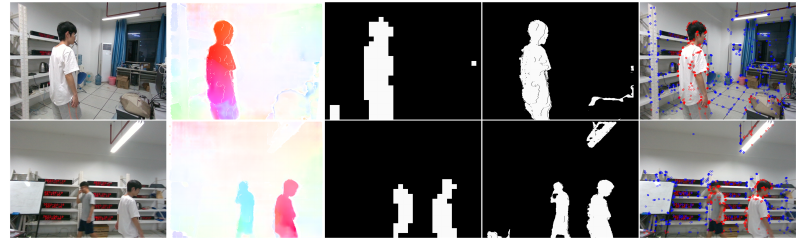
Figure 9. The experimental cases in our real environment. The first row is a scene of a single person exercising, and the second line shows two people walking in opposite directions. The white in the two mask images represents the dynamic part, and the black represents the background